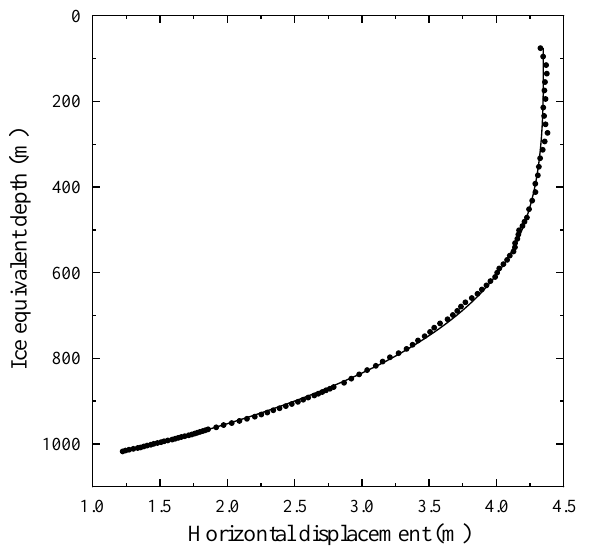
Figure 5. Power-law velocity profile fit (line) to the horizontal dis- placement data (dots) of Morgan et al. (1998).